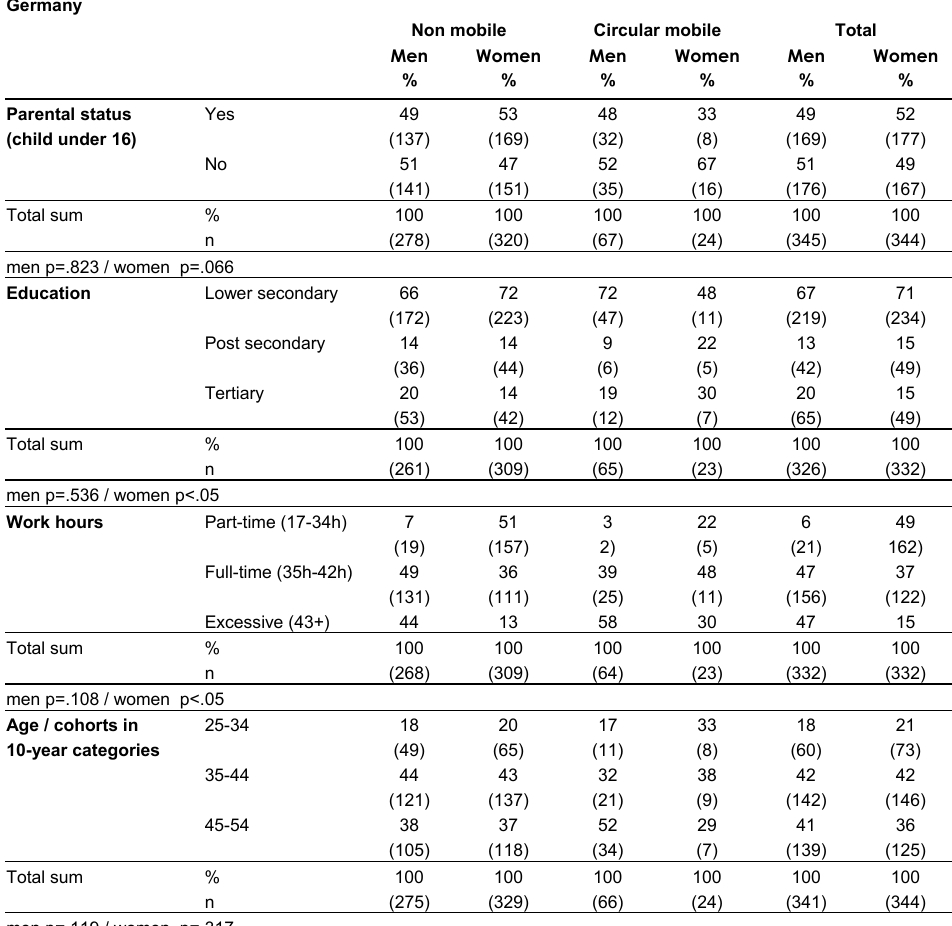
Table 1: Frequencies of German men and women, living in partnerships, by mobility